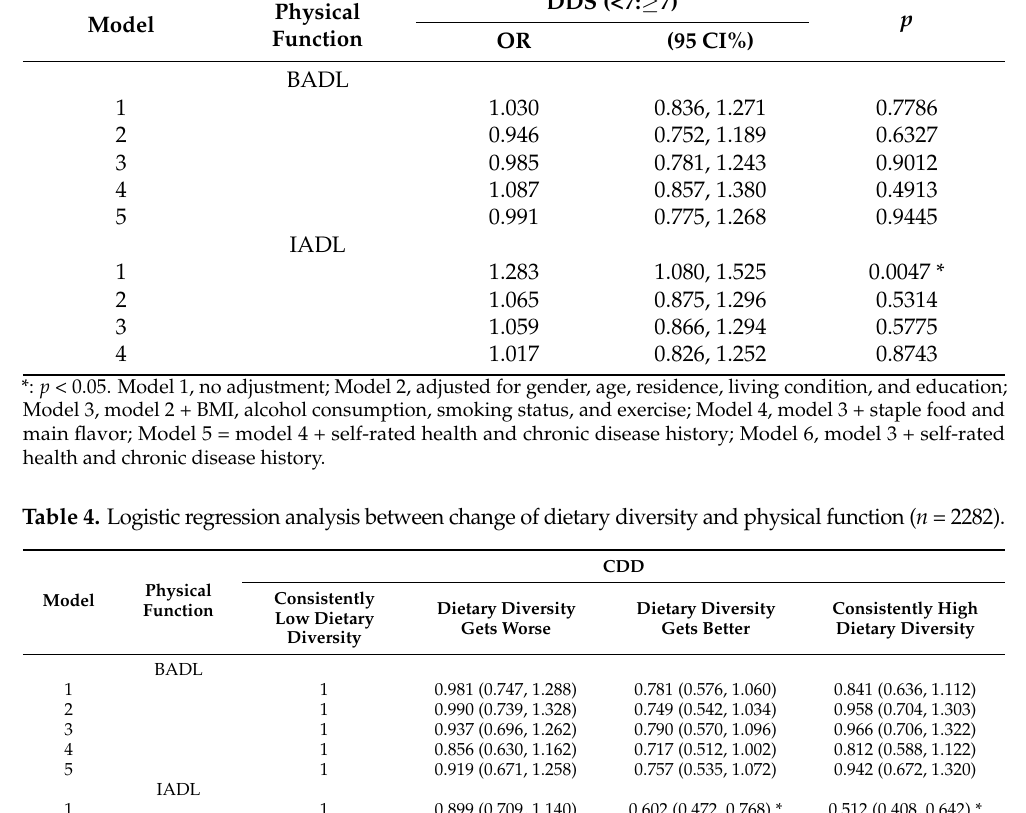
Table 3. Logistic regression analysis between dietary diversity and physical function ( n = 2282). Model